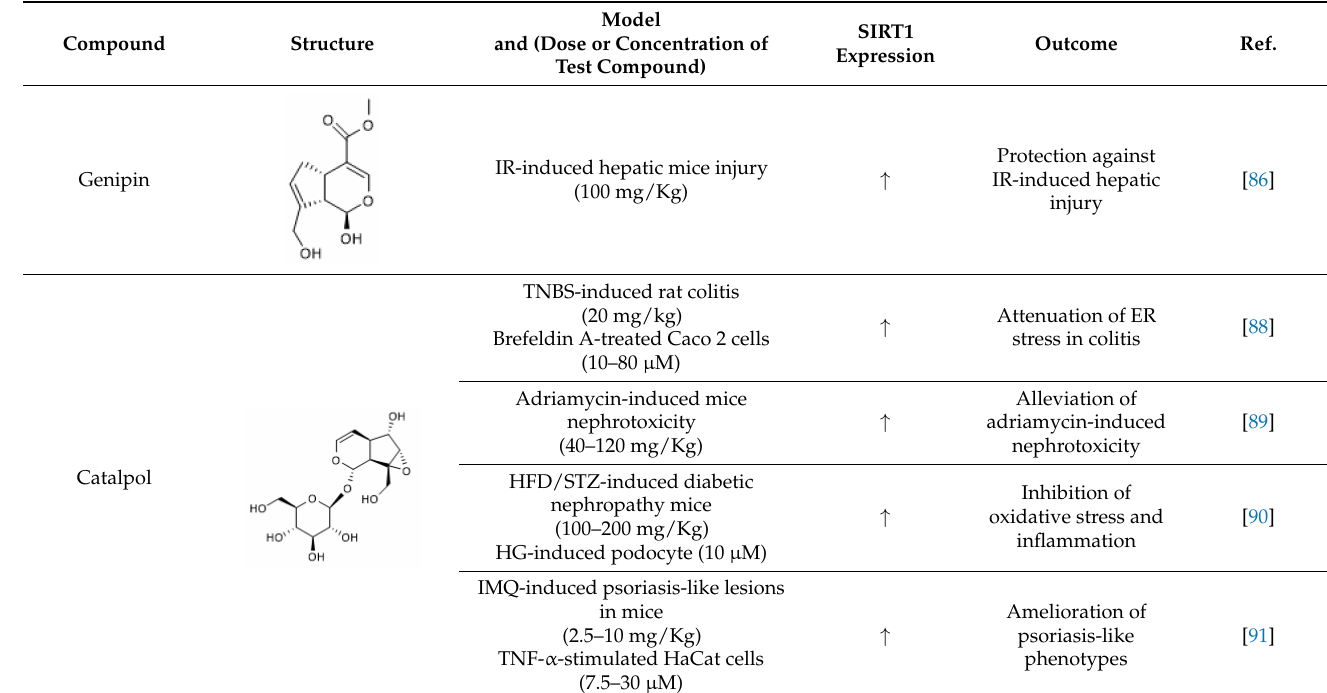
Compound Structure